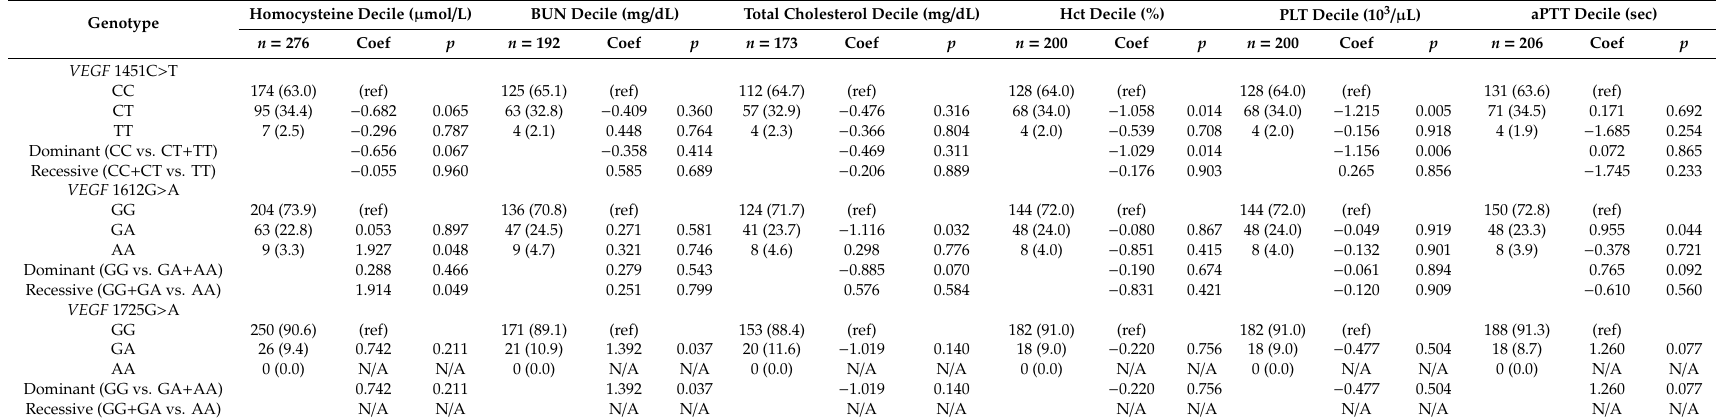
Table 7. Multiple linear regression analyses of clinical variables in Korean RPL patients according to the quintiles of clinical variables.